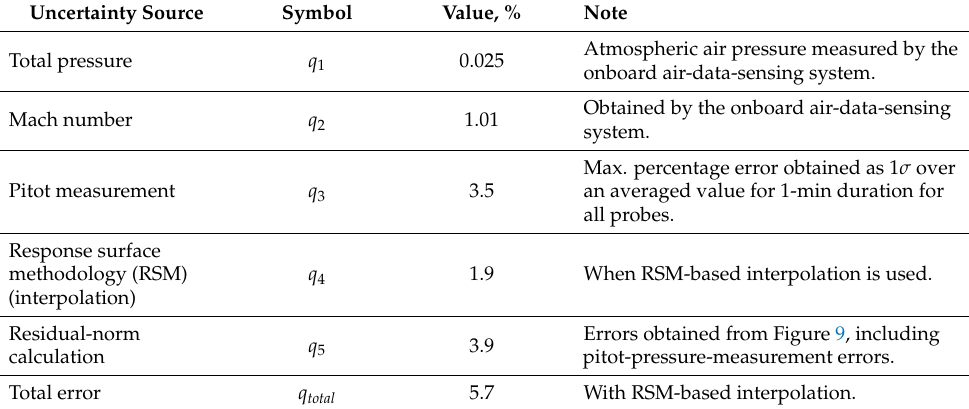
Table 1. Summary of possible uncertainty sources with or without RSM-based